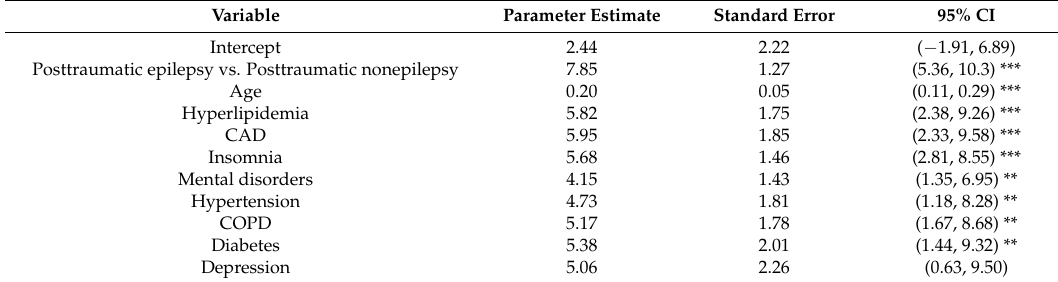
Table 6. Stepwise regression analysis for frequency of medical visits per year after propensity-score